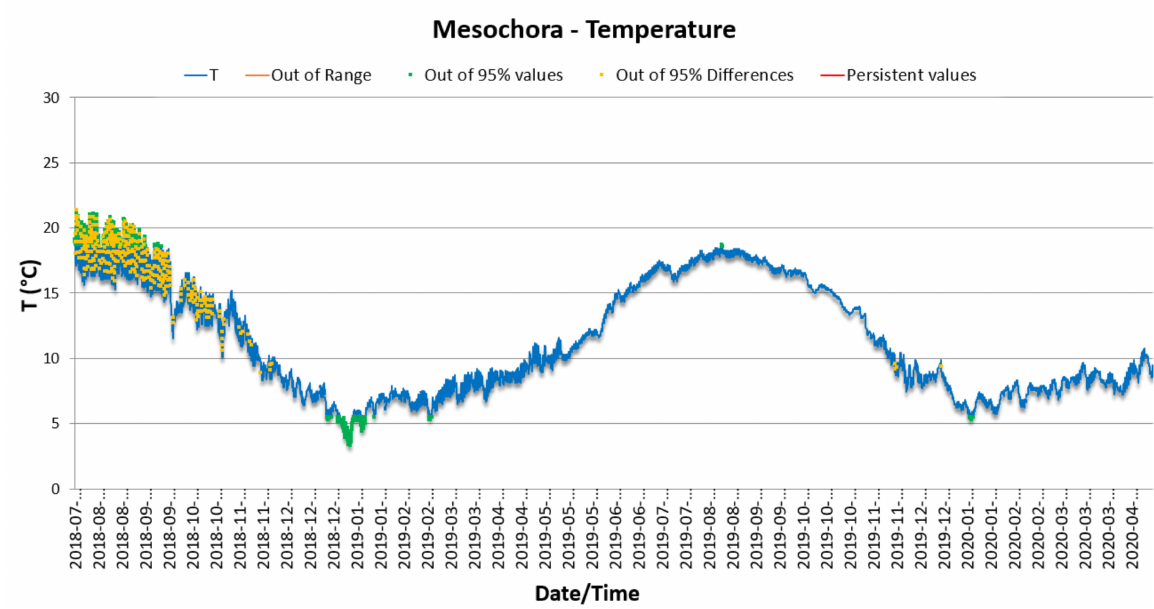
Figure 4. Change of water temperature (T) (blue line) on an hourly basis at Mesochora station and marking of values that are outside the 2.5% and 97.5% percentiles of observations (green color) and outside the 2.5% and 97.5% percentiles of absolute differences of consecutive observations (yellow color). No out of allowable range T values (orange color) or unchangeable T values for more than two days of continuous recording (red color) have been